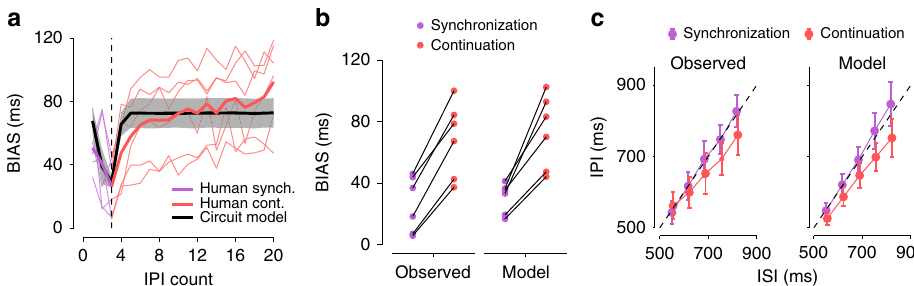
Fig. 8 Circuit model captures systematic biases in human behavior during Bayesian synchronization/continuation. a Overall BIAS in the synchronization/continuation task. BIAS was calculated as in Fig. 7. Purple and red lines indicate BIAS for human subjects during synchronization and continuation, respectively. Thin lines indicate individual subjects. Thick lines indicate the mean across subjects. The black line with shading indicates the mean and standard deviation of the BIAS in the circuit model fi t to individual subjects. The vertical dashed line marks the transition from synchronization to continuation. b Observed and model BIAS for individual subjects during each phase of the task. Lines connect data points for each subject or their respective model fi ts. c Inter-production-interval (IPI) for different inter-stimulus-intervals (ISI) for an example subject (left) and the circuit model fi t to that subject's behavior (right). Dashed lines indicate unity. Behavioral data for all panels modi fi ed from Narain et al. 44 . Error bars represent standard deviation across trials, n = 21 simulation trials for each